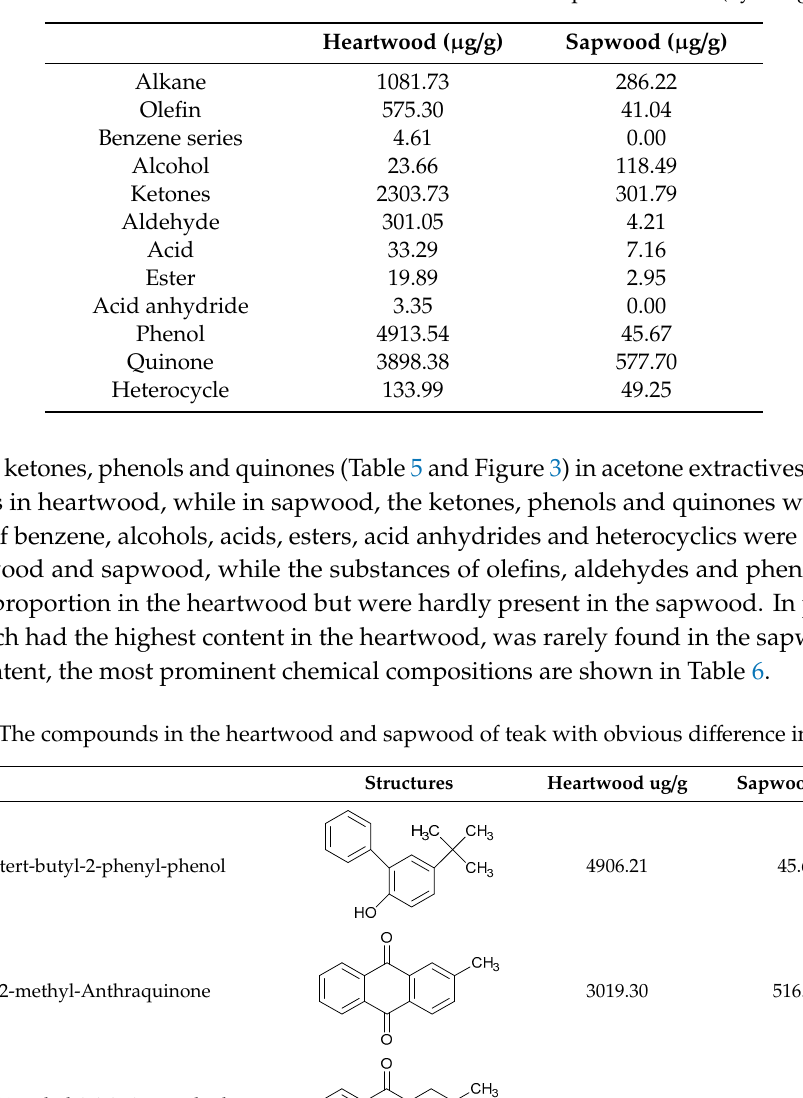
Table 5. The content of acetone extractive in heartwood and sapwood of teak (by category).